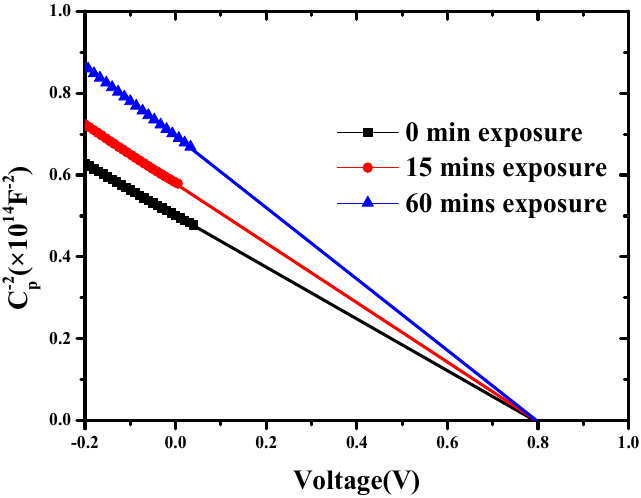
Figure 4. C–V measurements of the planar Si/PEDOT:PSS solar cells with different exposure times.